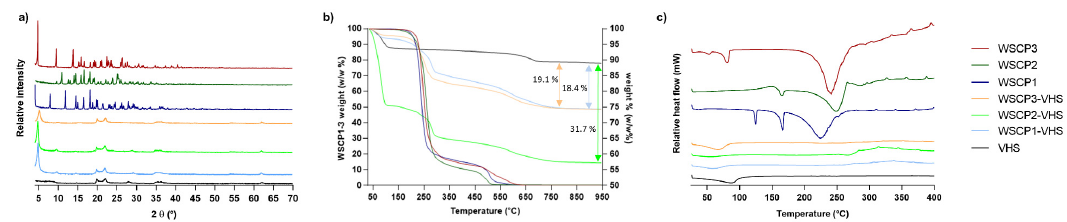
Figure 4. Nanohybrids and raw components analyzed by ( a ) X-Ray Power Diffraction (XRPD), ( b ) thermogravimetric analysis (TGA), and ( c ) differential scanning calorimetry (DSC).